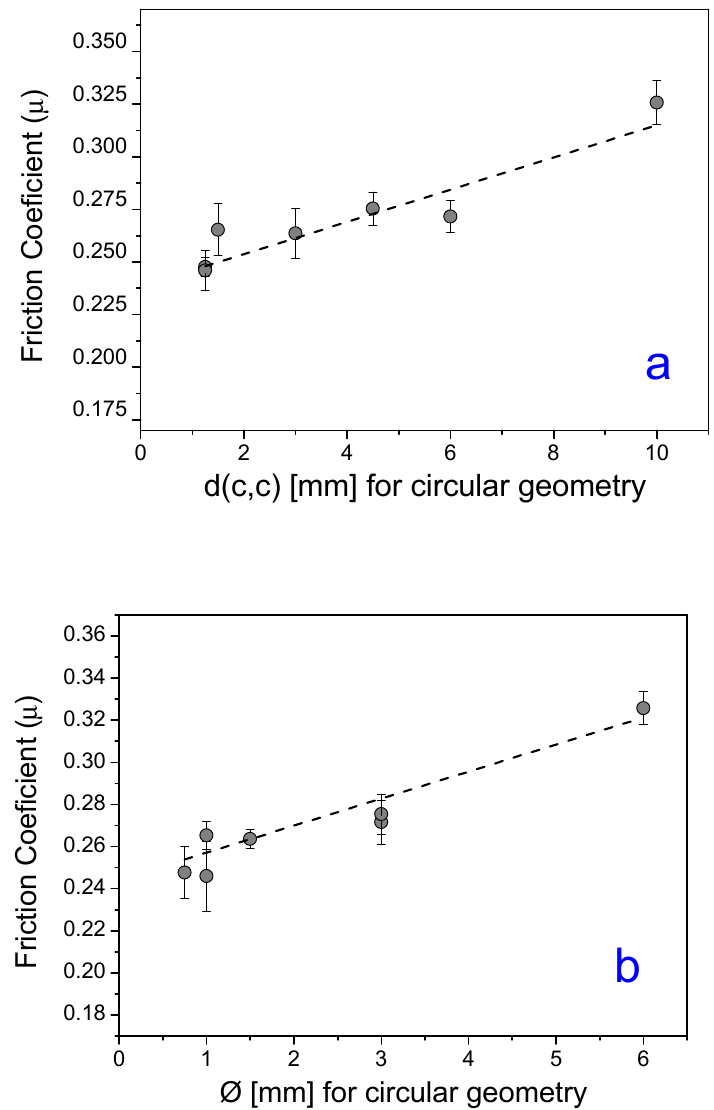
Figure 7. ( a ) Relation between d(c,c) and µ ; ( b ) Relation between Ø and µ ; both for manufactured tools Figure 7. a ) Relation between d(c,c) and µ ; b ) Relation between Ø and µ ; both for manufactured tools with circular structure surface with circular structure surface geometry.